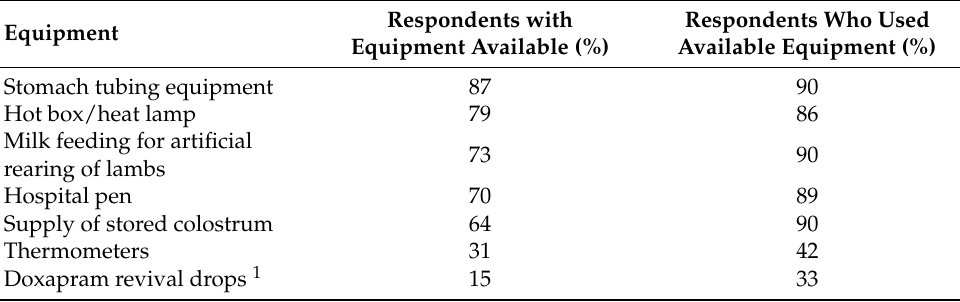
Table 6. Equipment available on farm and used to improve lamb survival ( n = 177).